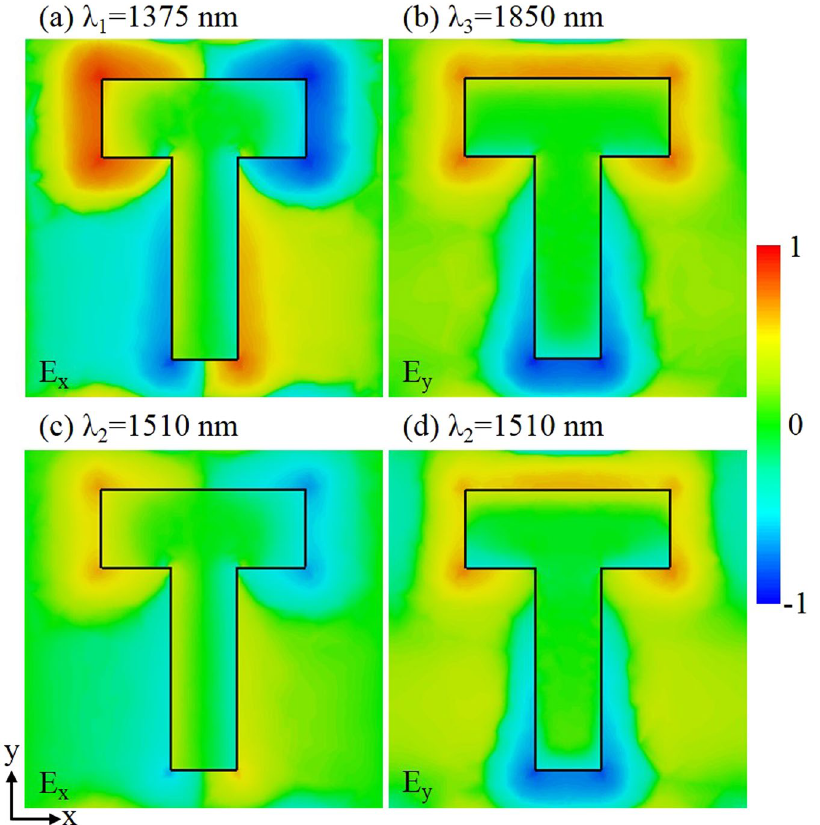
Figure 5. Simulated electric field distributions of plasmonic dipolar resonant modes supported in T-shaped antenna under linear polarization excitations at normal incidence ( a ) at the plasmonic resonance of horizontal arm λ 1 = 1375 nm along the x -polarized direction, ( b ) at the plasmonic resonance of vertical arm λ 3 = 1850 nm along the y -polarized direction, and ( c ), ( d ) at the crossing point of transmission amplitude spectra along both polarized